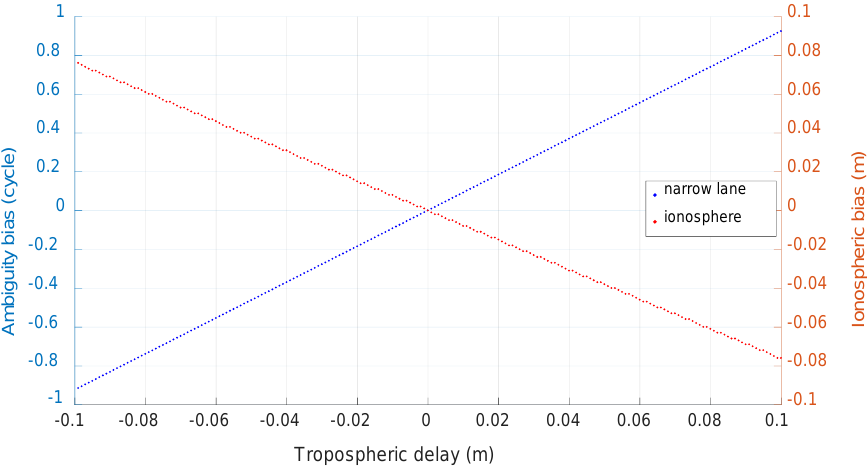
Note that tropospheric error is also ignored and its effect on ambiguity resolution is studied as shown in Figure 6. We can see that the effects on both ambiguity and ionospheric delay are obvious, the bias of narrow-lane ambiguity can reach 0.924 cycle with ignored tropospheric error of 0.1 m and 0.185 cycle with tropospheric error of 2 cm.